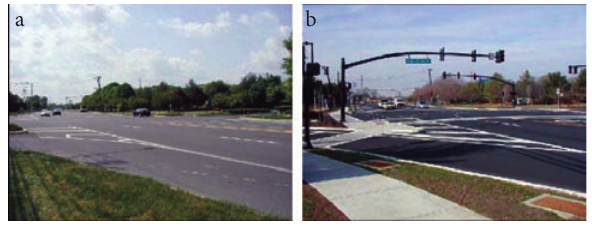
Fig. 6. Safety enhancements at intersections: a – unsignized, open mode; b – textured crosswalks and expanded islands